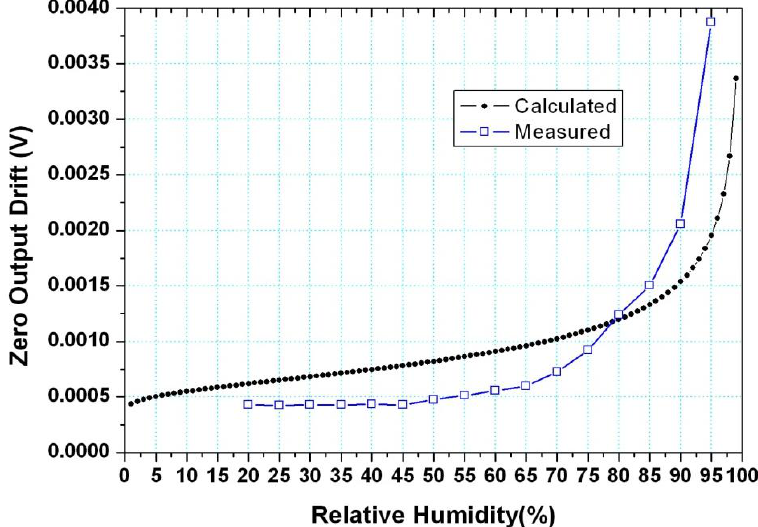
Figure 4. Sensor zero drift caused by charge leakage through water film in the surface of